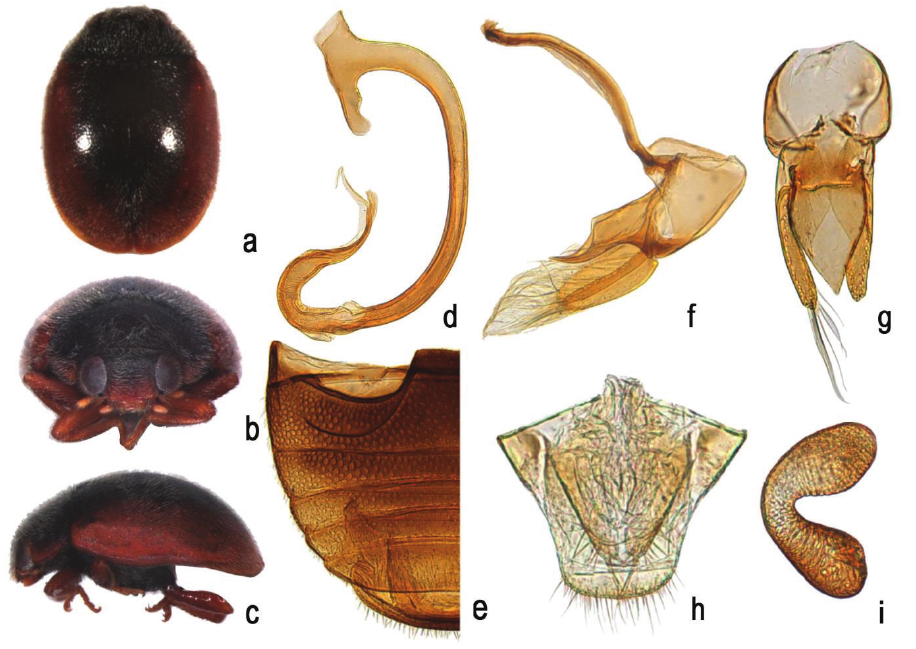
Figure 2. Scymnus ( Scymnus ) contortubus Rashid, Chen & Wang, sp. n.: a dorsal view b anterior view c lateral view d penis e abdomen f tegmen, lateral view g tegmen, ventral view h ovipositor i spermatheca. Female genitalia : Coxites elongate triangular, 2.5 times as long as wide,